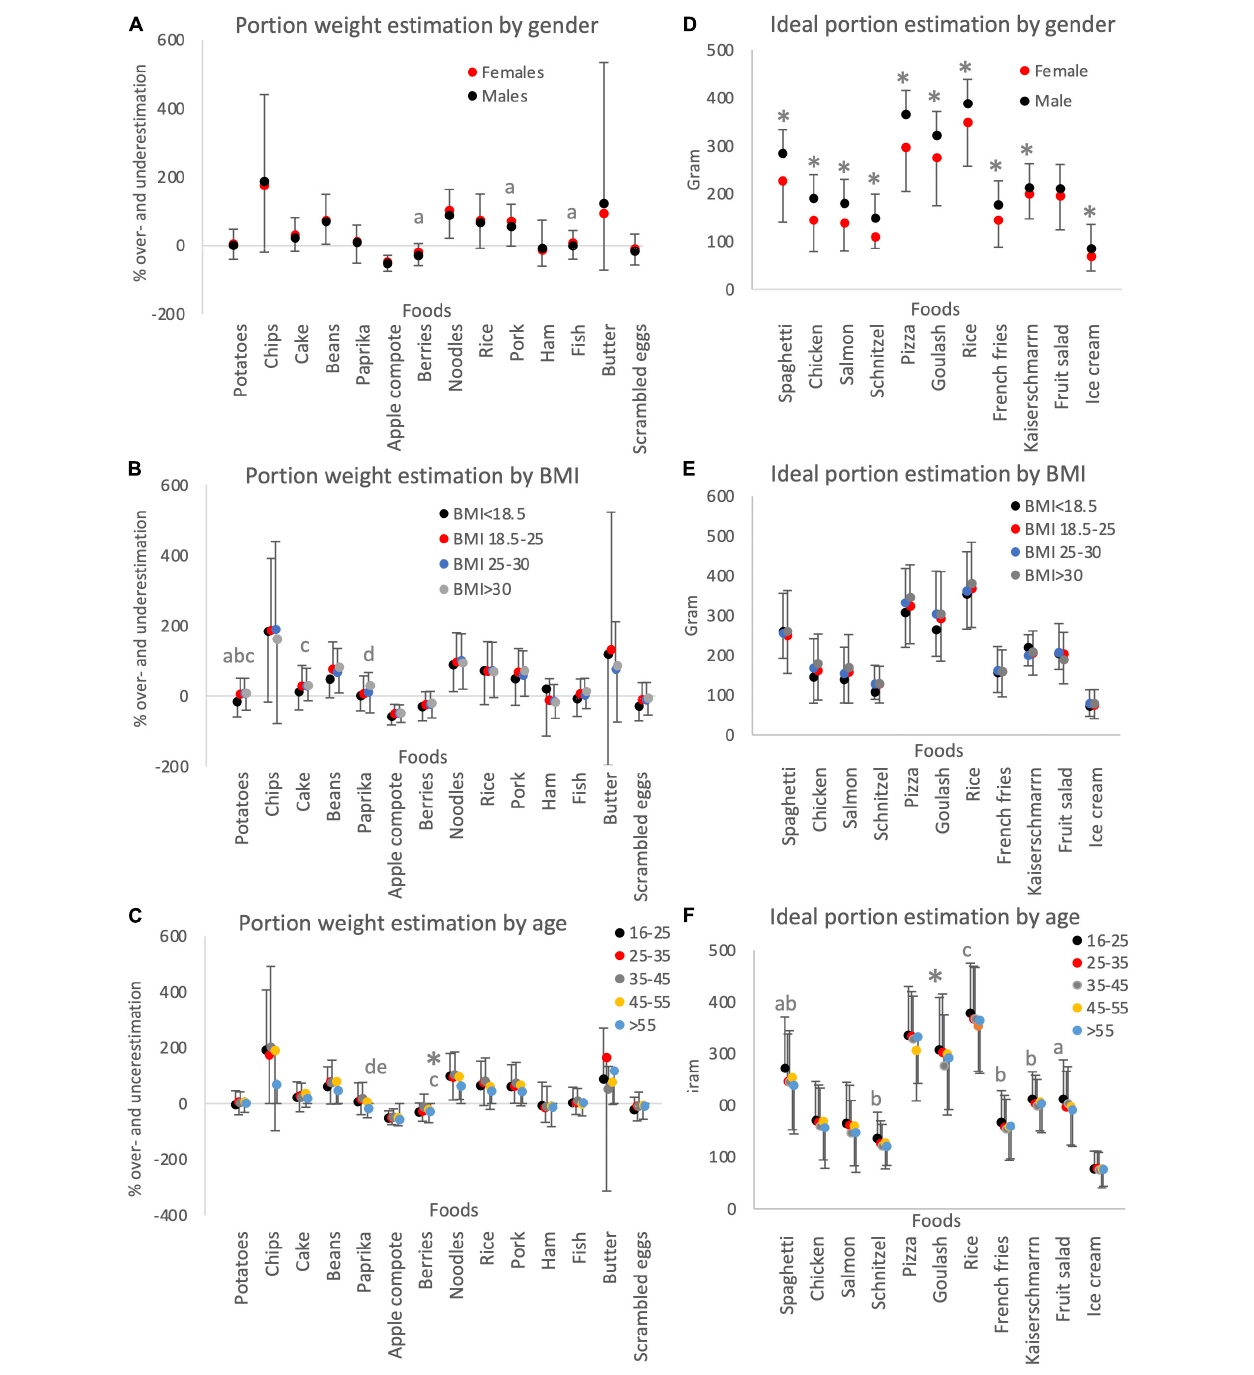
FIGURE 1 | The impact of the main factors affecting portion estimation. The data collected for portion weight estimation (A–C) and ideal portion estimation (D–F) were analyzed for subgroups identified based on gender (A,D) , BMI (B,E) , and age (C,F) . The statistical difference in (A,D) were determined by Students’ t -test for independent samples with a p -value threshold accounting for multiple testing for study I p < 0.0036 and for study II p < 0.045. In (A) , p < 0.05 was indicated with a. One-way ANOVA was performed to compare groups in (B,C,E,F) . *Indicates statistical significance for (C,D,F) . In (B) , a indicates p < 0.05 between groups BMI < 18.5 and BMI 18.5–25; b indicates p < 0.05 between groups BMI < 18.5 and BMI 25–30; c indicates p < 0.05 between groups BMI < 18.5 and BMI > 30; d indicates p < 0.05 between groups BMI 18.5–25 and BMI > 30. In (C,F) , ∗ indicates statistical significance between age groups 16–25 and 35–45; a indicates p < 0.05 between age groups 16–25 and 25–35; b indicates p < 0.05 between age groups 16–25 and 35–45; c indicates p < 0.05 between age groups 16–25 and 45–55; d indicates p < 0.05 between age groups 25–30 and > 55; e indicates p < 0.05 between age groups 35–45 and > 55. The data are presented as mean ±